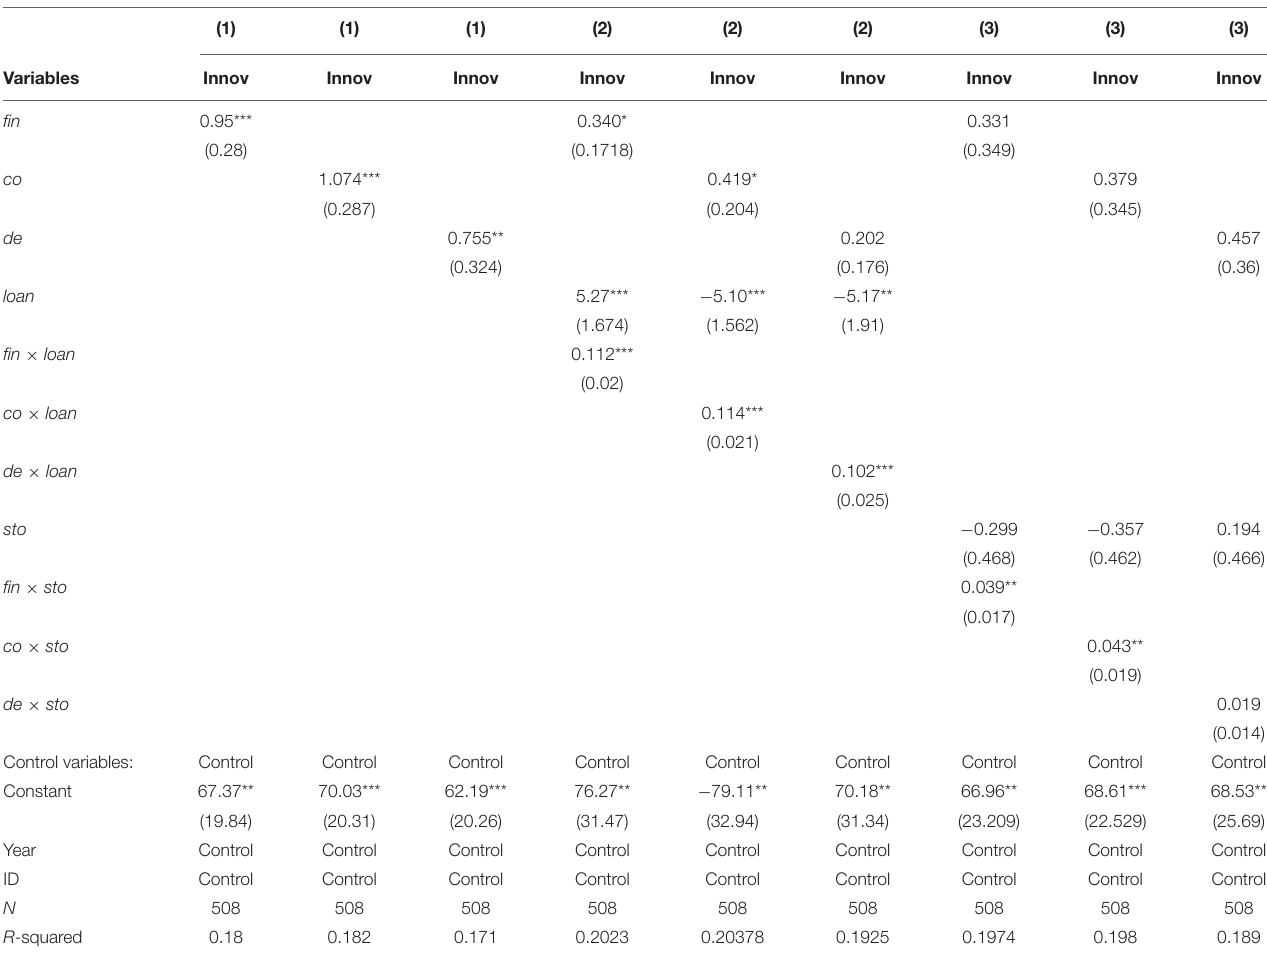
TABLE 6 | Non-state-owned